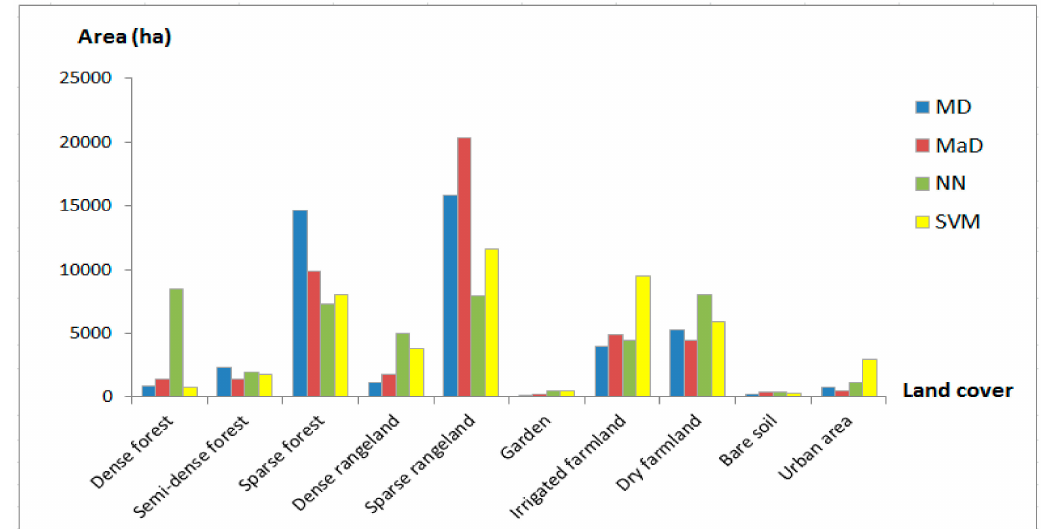
Figure 10. Area of di ff erent land covers by di ff erent